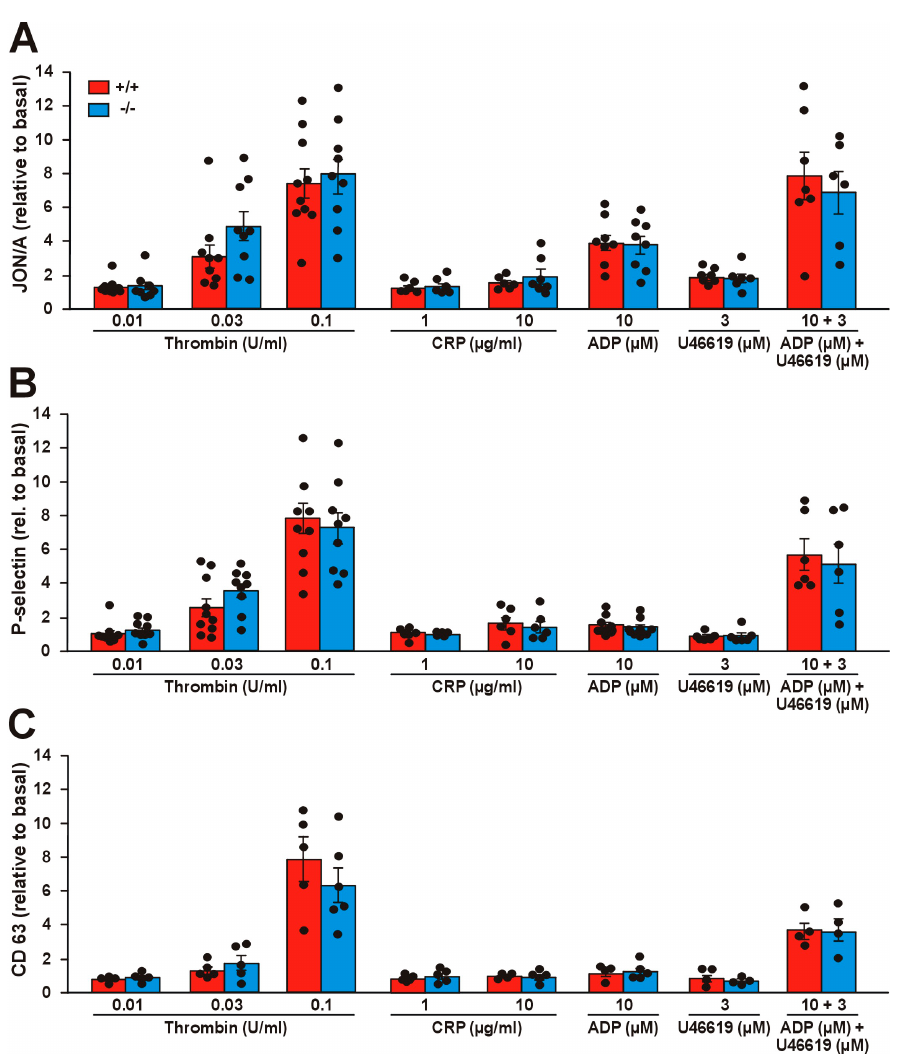
Figure 3. Integrin activation and secretion in Coro1a deficient platelets. Integrin activation ( A ), P-selectin exposure ( B ), and CD63 exposure ( C ) were determined in PRP upon stimulation with the indicated doses of agonists for 20 min at 37 °C and subsequent flow cytometry analysis. The data (median fluorescence intensity) represent the mean ± SEM of 5–9 independent experiments expressed relative to basal (unstimulated) platelets. No statistically significant differences were found between WT and KO, Student’s t -test.